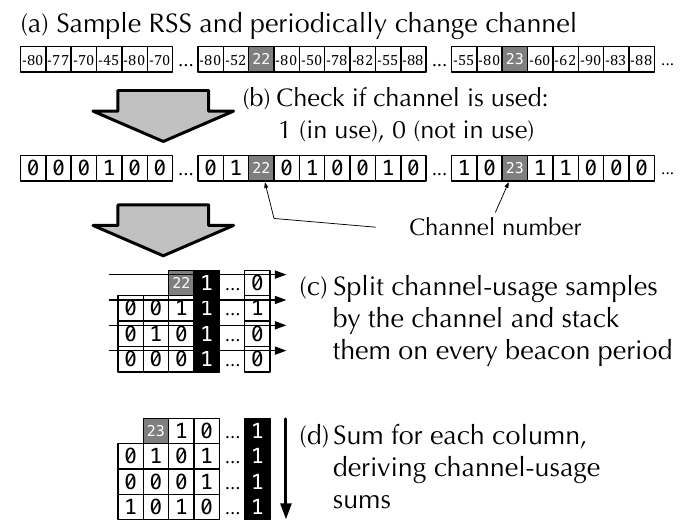
Figure 3. Overview of multi channel AP signal detection in multi-ch-RSS measurement